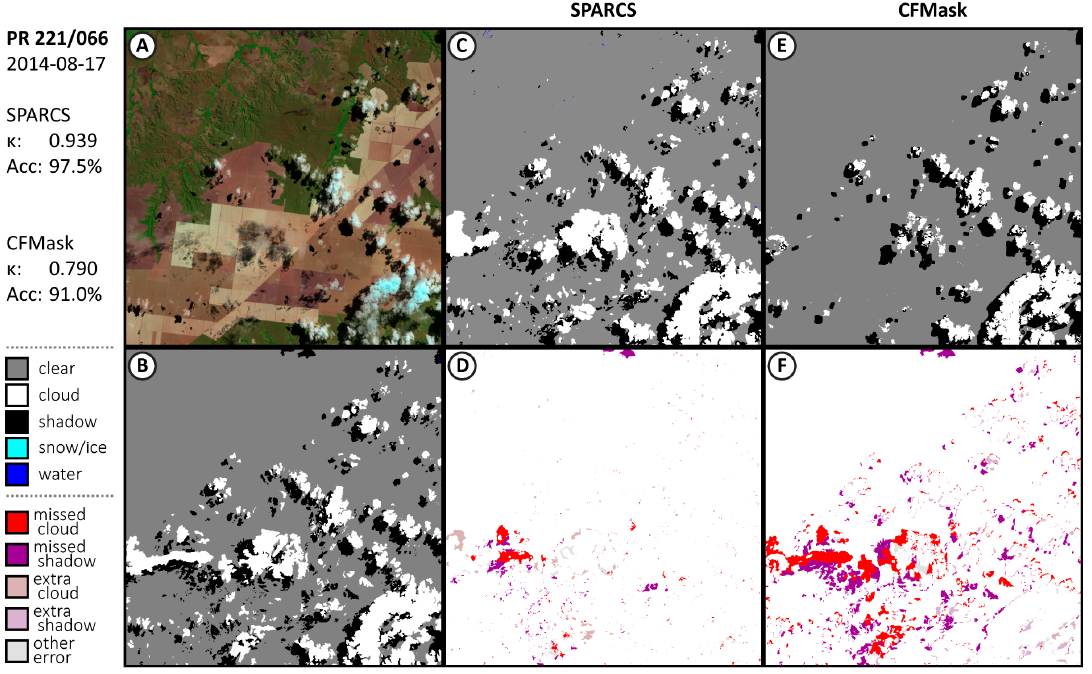
FigureA6. ResultsforvalidationtestimagePR221 / 066, withfalsecolorimageusedduringinterpretation Figure A6. Results for validation test image PR 221/066, with false color image used during ( A ), the manually labeled interpretation ( B ), generated masks from SPARCS ( C ) and CFMask ( E ), interpretation (A), the manually labeled interpretation (B), generated masks from SPARCS (C) and and respective spatial distribution of errors ( D , F CFMask (E), and respective spatial distribution of errors (D, F).